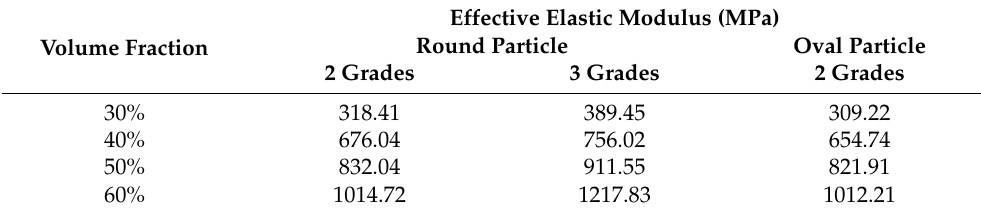
Table 3. Effective elastic modulus of different shapes and gradations.